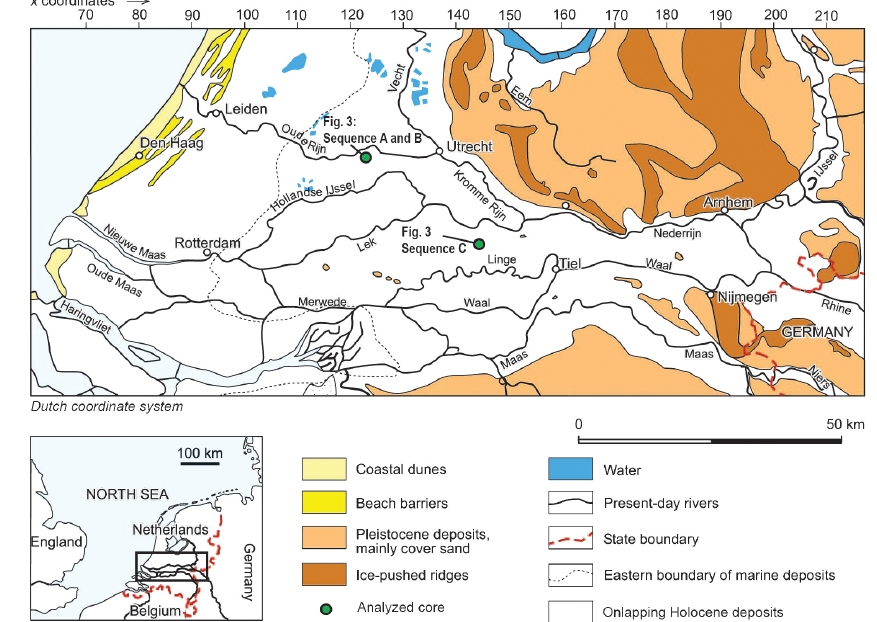
Figure 1. The Holocene Rhine-Meuse delta, the Netherlands; rivers run E–W. x coordinates according to the Dutch map coordinate system (in kilometers, after Stouthamer and Berendsen, 2001 and Stouthamer et al.,